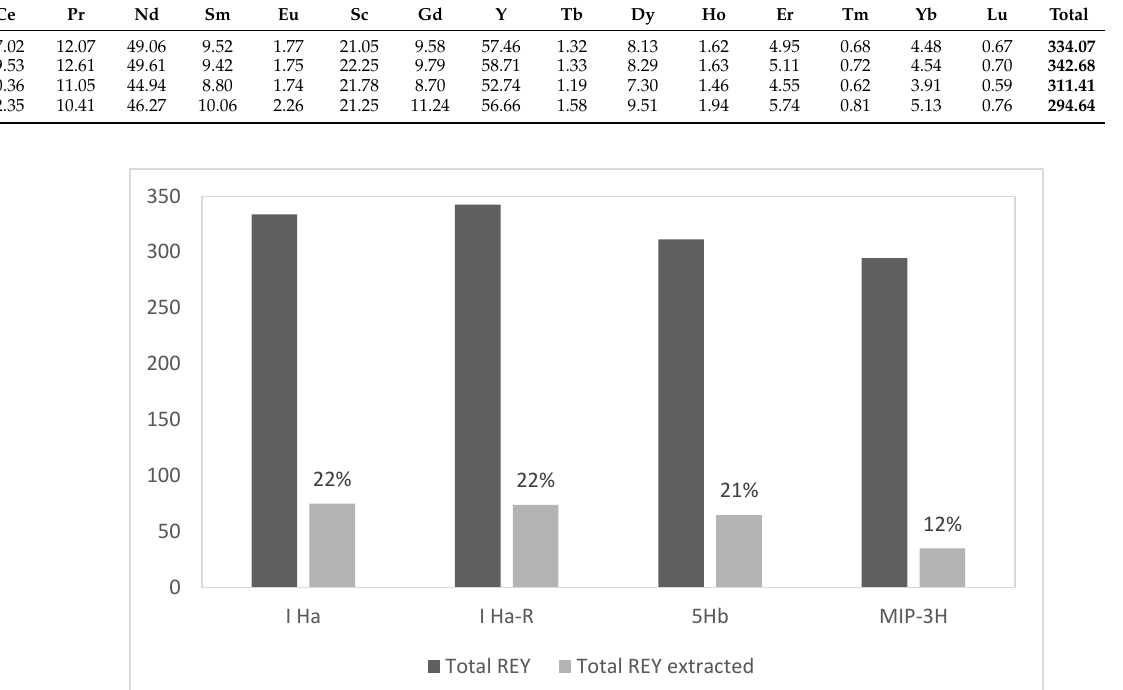
Figure 1. Total REY and amount extracted from the whole rock.